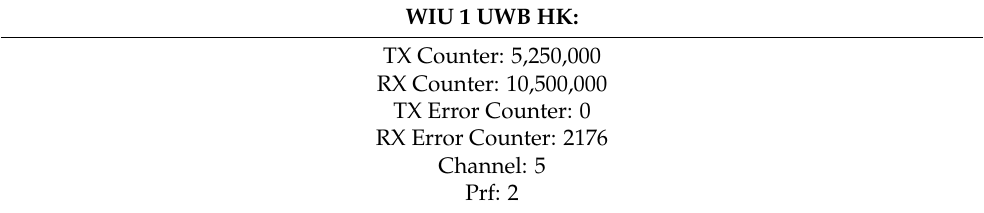
Table 6. Received UWB Housekeeping Data from WIU Gateway.